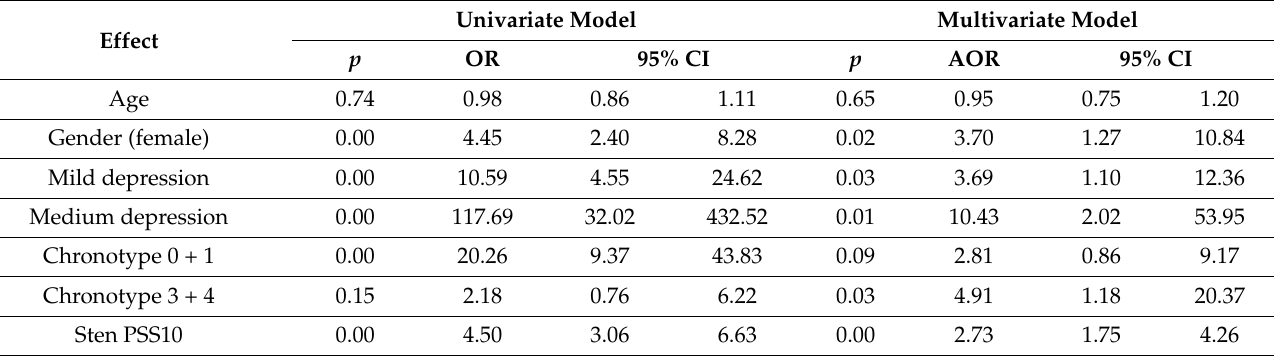
Table 6. Logistic regression analysis for type D personality